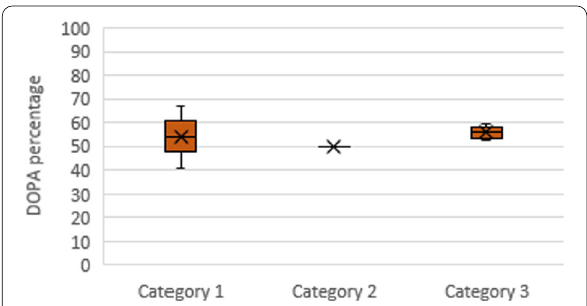
Fig. 9 Comparison among different methods of modification determination. Category 1, amino acid analysis; Category 2, manual analysis; Category 3, ABCS method from a similar article with permission (Lin and Israelachvili